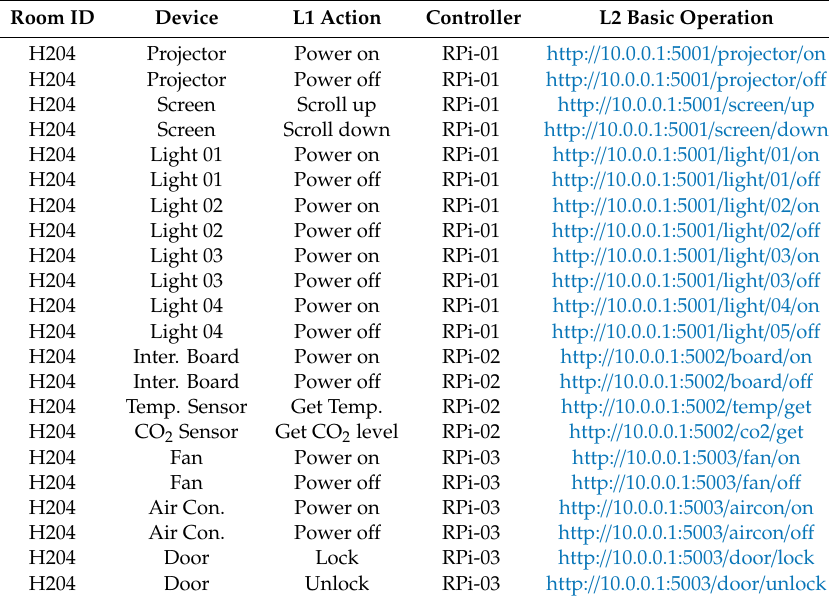
Table A4. Layer 2 basic operations registered on the central web